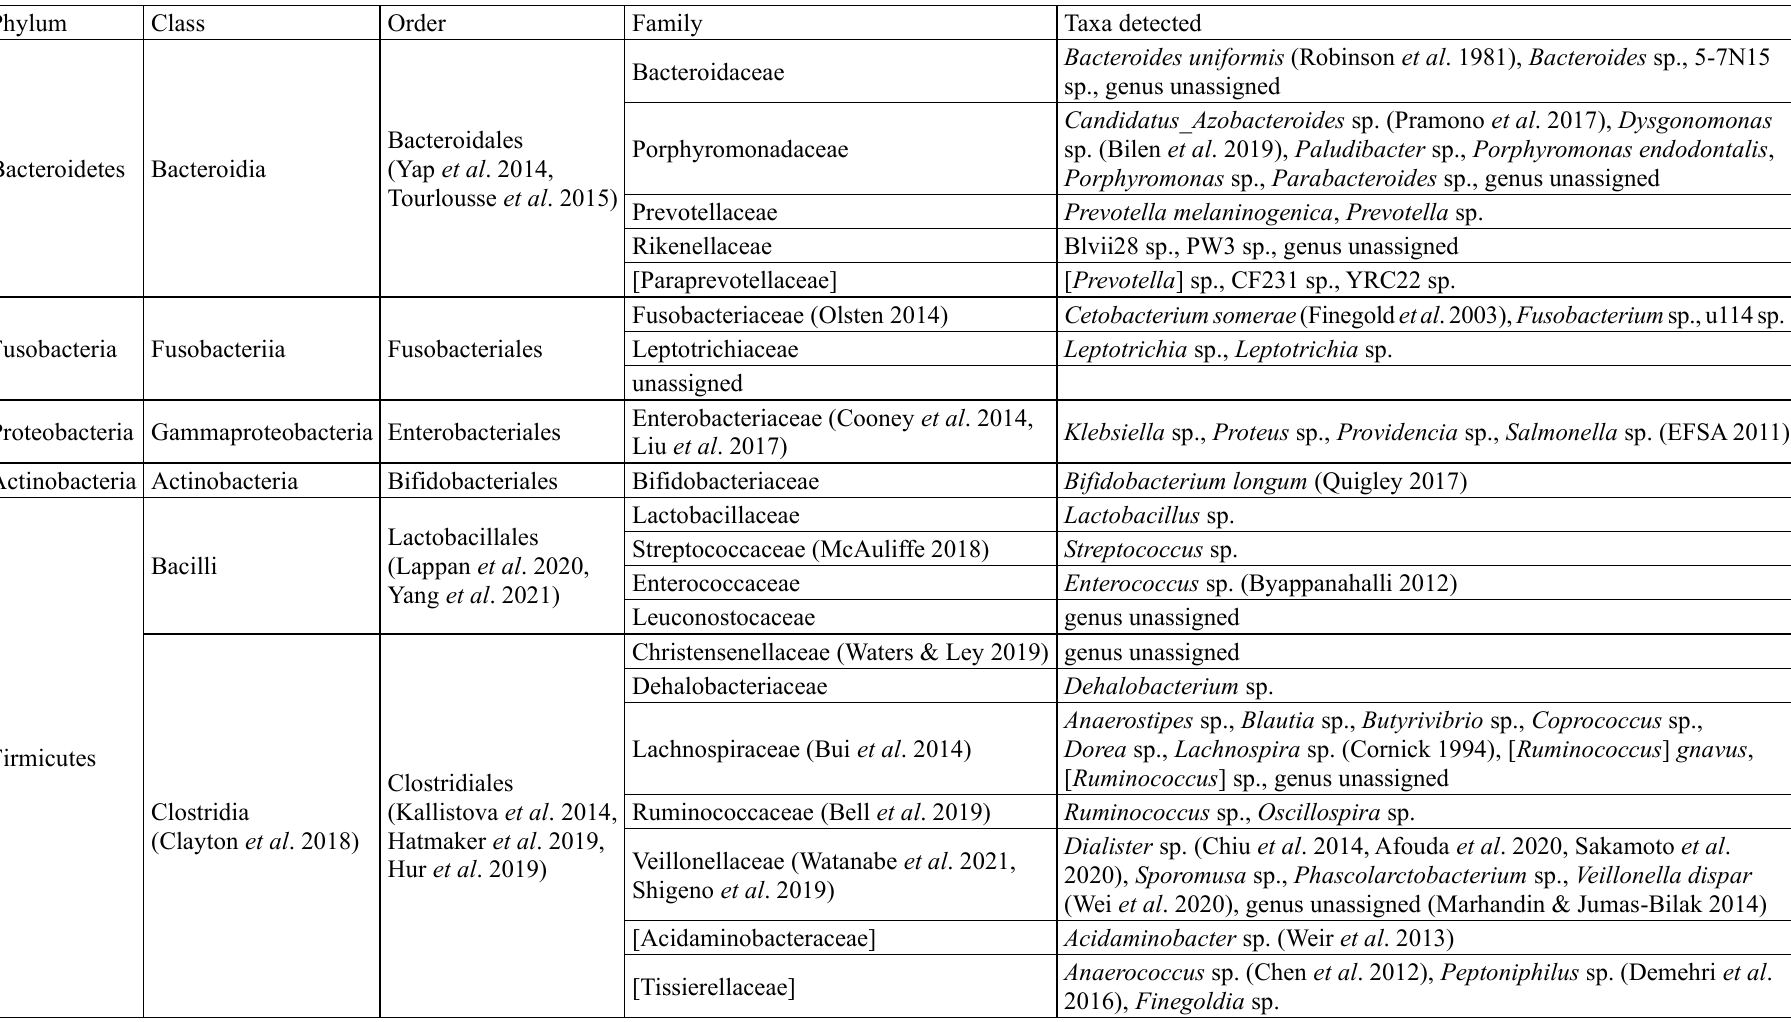
Table 1. Classified list of 56 gut-bacterium taxa detected in soil and water samples collected from Sarobetsu mire, northern Japan during the snow-free periods of 2018 and 2019. References used to support exclusion or inclusion as gut bacterial taxa are provided (in